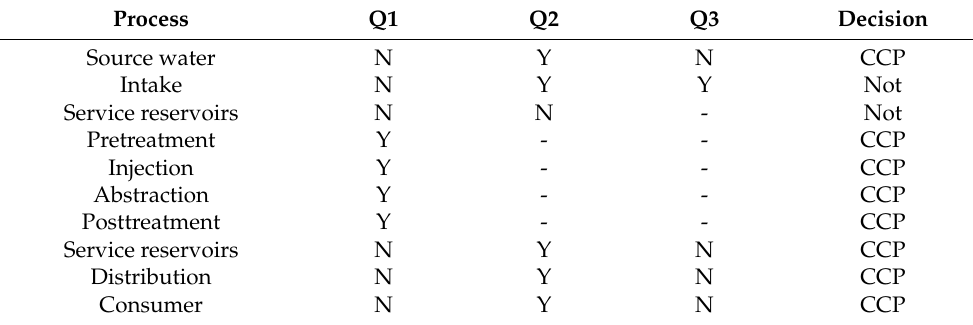
Table 5. Answers and decision in the decision tree for determining the